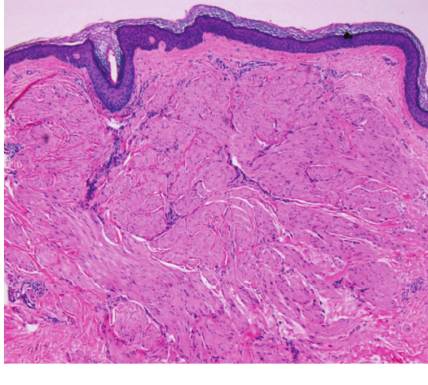
Figure 1: H&E 4x.